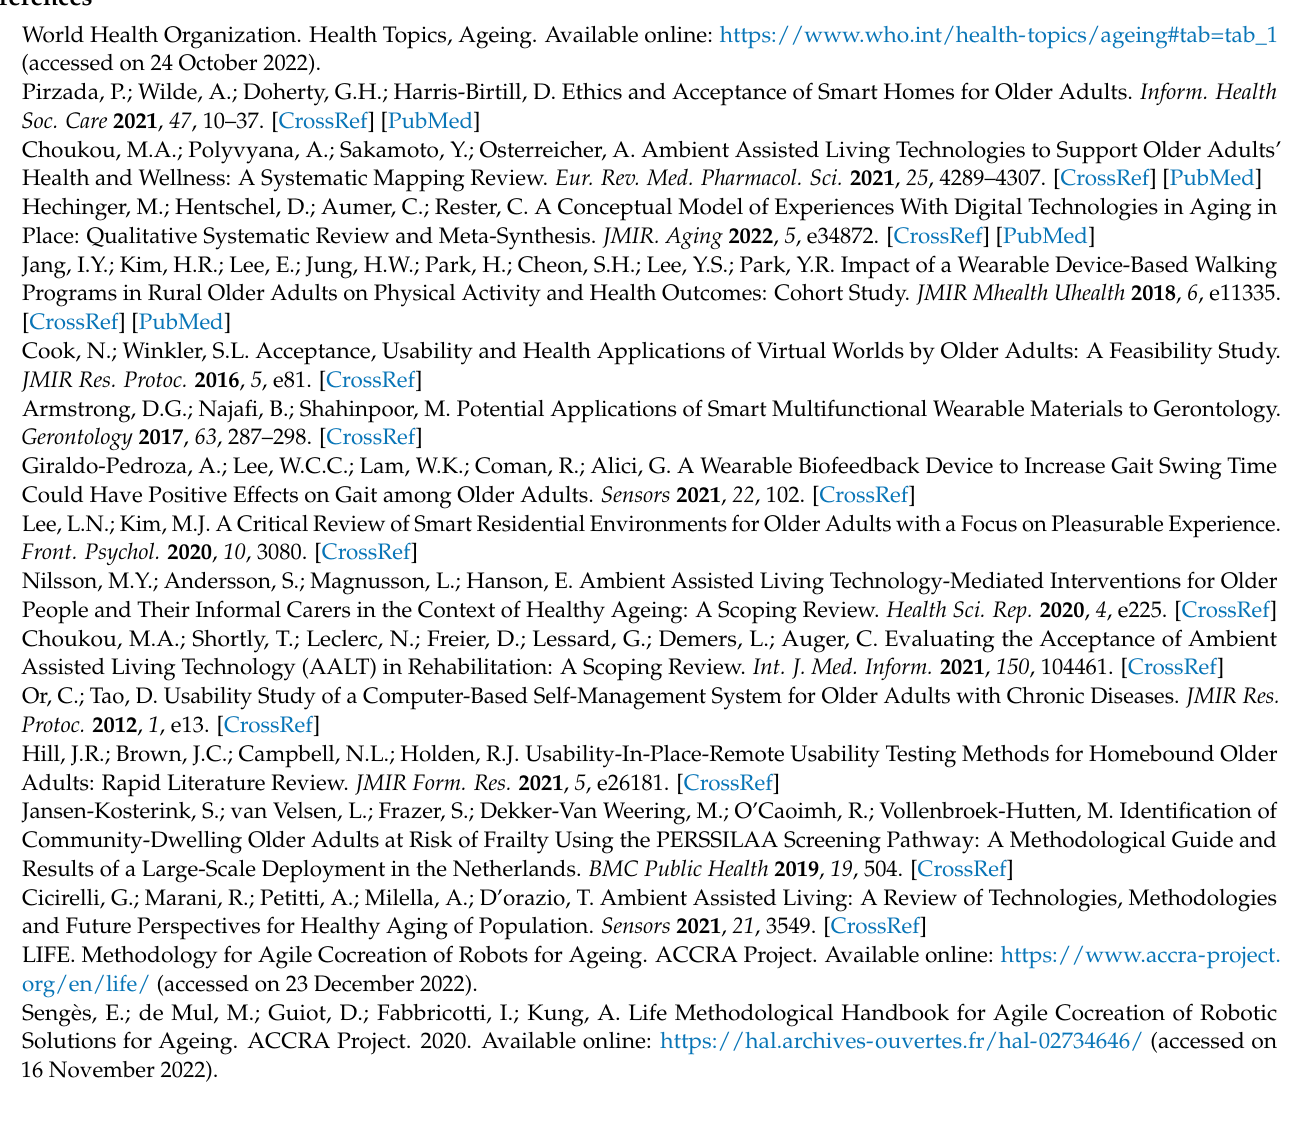
* a very strong negative correlation but very small sample. Bold correlation values are the sinificant ones. Legend : R P : Pearson coefficient; R S : Spearman coefficient; System Usability Scale (SUS); Training Evalua- tion Inventory (TEI) domains: Perceived Usefulness (PU); Perceived Difficulty (PD); Subjective Knowledge Gain (SKG); Almere Model Questionnaire (AMQ) domains: Facilitating Conditions (FaC), User Experience Questionnaire